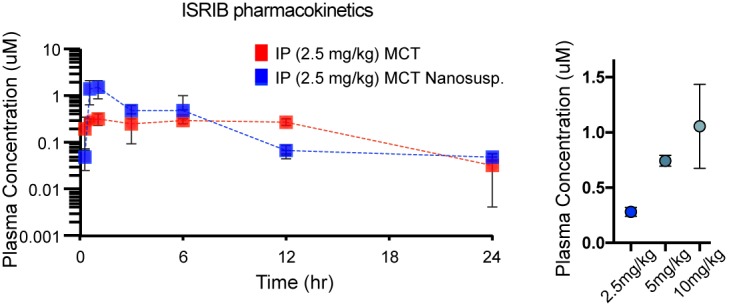
Pharmacokinetic analysis in mice dosed IP with ISRIB formations in MCT (red) and nanosuspenion in MCT (blue) over one day, as determined by plasma concentration (left).Plasma concentrations measured in a separate cohort of mice 8 h post IP administration of ISRIB in MCT at 2.5, 5 and 10 mg/kg (right), suggesting the use of 10 mg/kg.